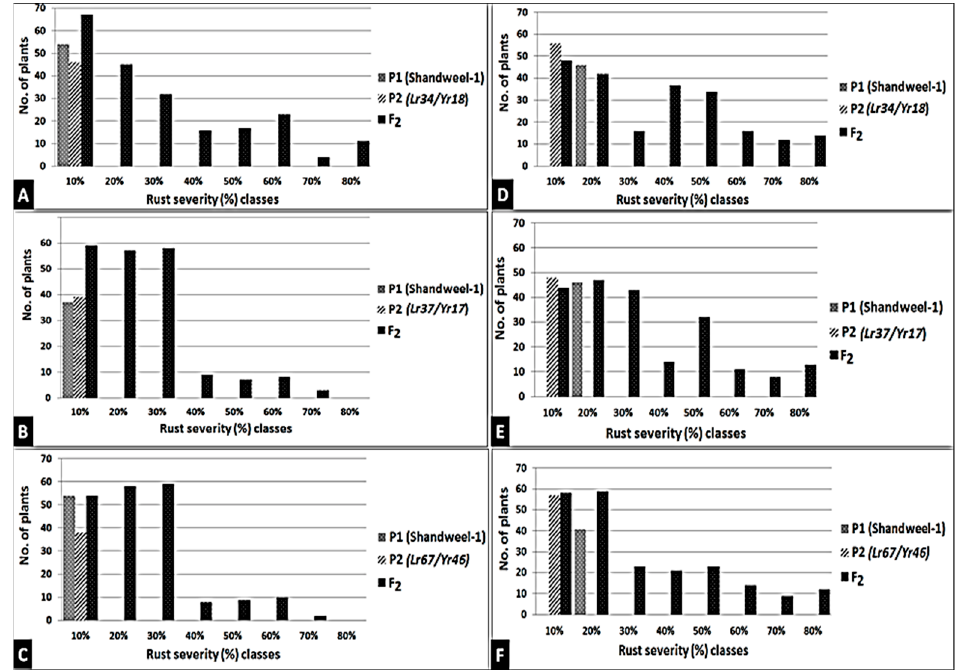
Figure 10. Frequency distribution of stripe and leaf rust severities (%) to Shandweel-1 × Lr34/Yr18 ( A ), Shandweel-1 × Lr37/Yr17 ( B ), and Shandweel-1 × Lr67/Yr46 ( C ) for leaf rust and Shandweel-1 × Lr34/Yr18 ( D ), Shandweel-1 × Lr37/Yr17 ( E ), and Shandweel-1 × Lr67/Yr46 ( F ) for stripe rust.